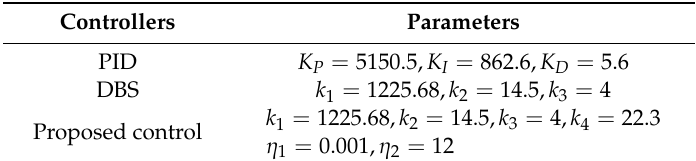
Table 3. Gains of controllers.